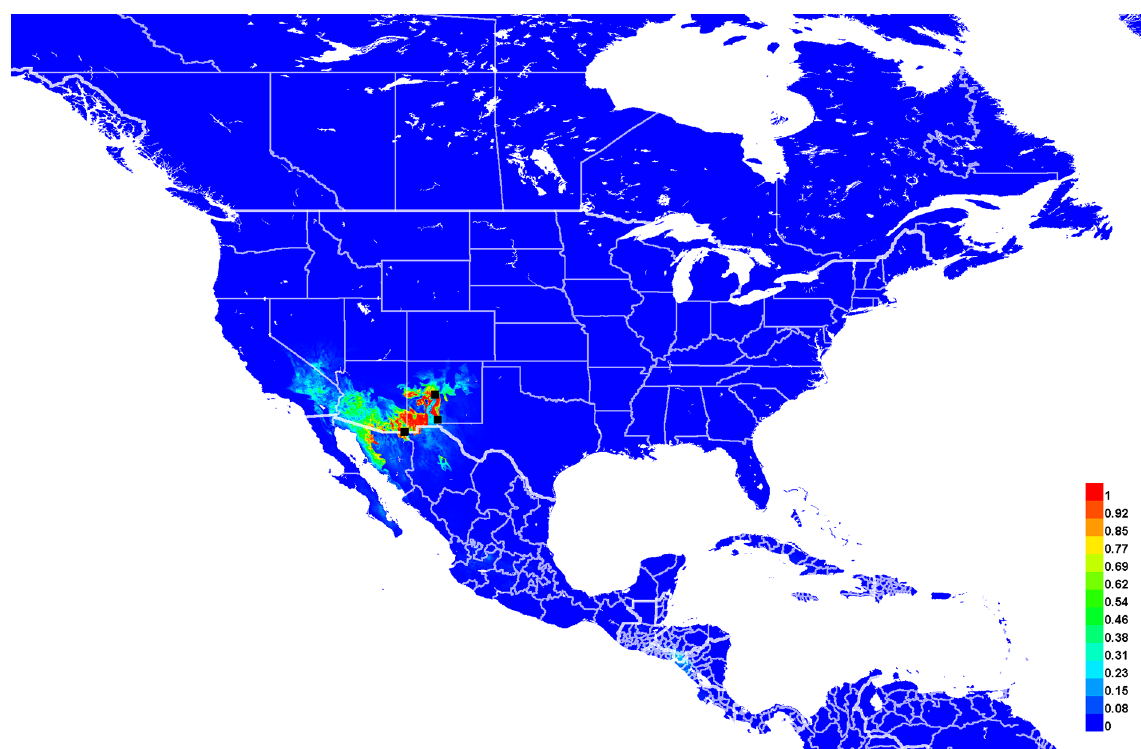
Fig. 37. Georeferenced collection records of Lasioglossum ( D. ) eophilus (Ellis, 1914) (black squares) and predicted distribution by maximum entropy ecological niche modeling in Maxent (colour shading). Warmer colours indicate higher cloglog probability of occurrence. Due to the very small number of records, this distribution should be interpreted with